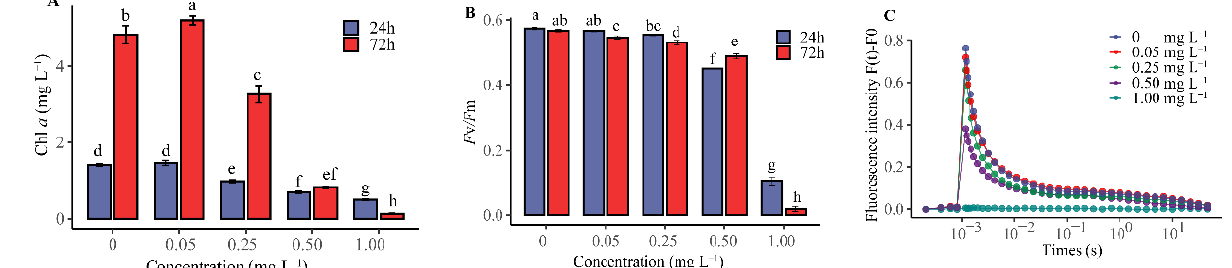
Figure 4. Algal cells were treated with cadmium at different concentrations for 24 h and 72 h. ( A ) Chlorophyll a content. ( B ) F v /F m. According to the one-way ANOVA test, different alphabet letters indicate a significant difference in different treatment groups at p < 0.05. ( C ) Treatment time of Q A − reoxidation kinetics of different concentrations of cadmium was 72 h.